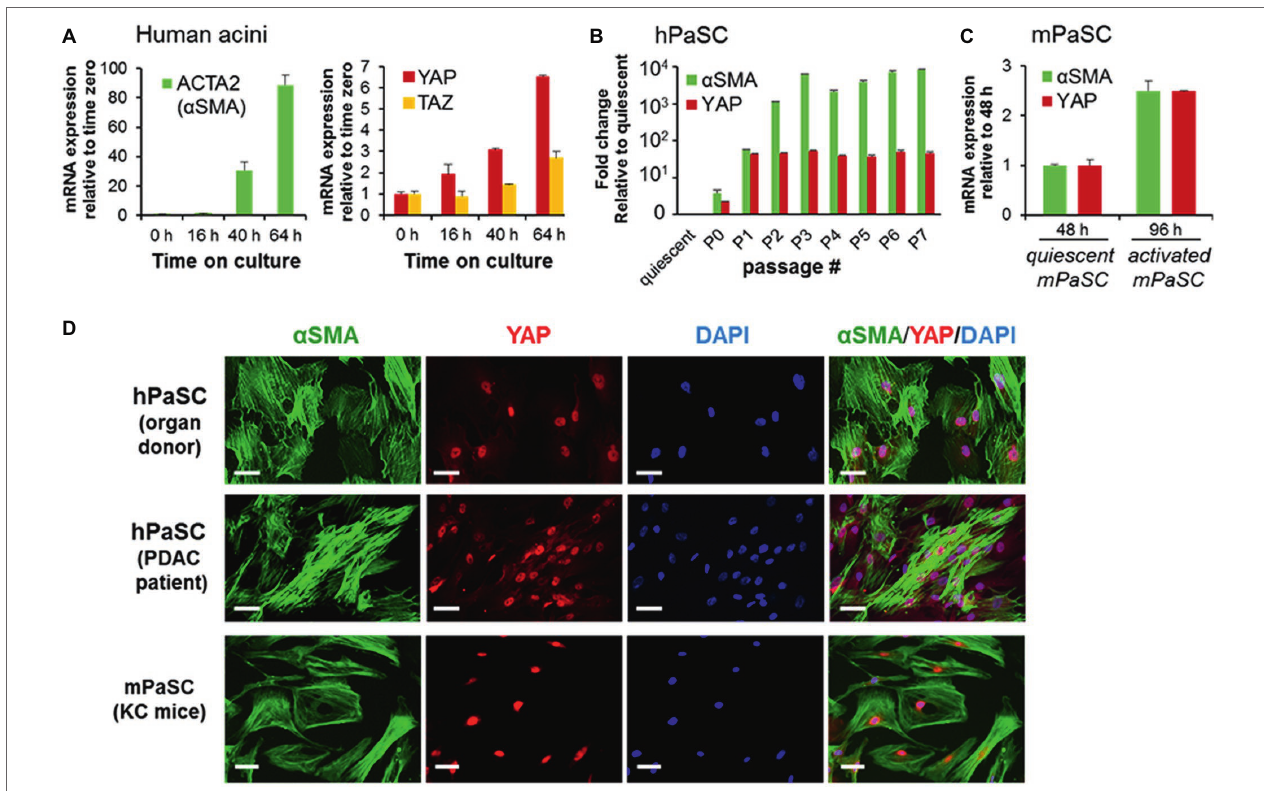
FIGURE 2 | PaSC activation is associated with sustained YAP upregulation. (A) Activated PaSC were obtained in culture from an acinar-ductal-metaplasia (ADM) experimental model using pancreatic acini from cadaveric pancreata from human donors. As sown in the graphs, upregulation of YAP and its homolog TAZ in the ADM system was concomitant with upregulation of α SMA, a recognized maker of activated PaSC. α SMA and YAP mRNA expression were determined by qPCR. (B) Quiescent PaSC isolated from cadaveric human pancreata (hPaSC) did not express YAP, but YAP levels markedly increased during PaSC activation in culture in parallel with upregulation of α SMA. Similar results were obtained in PaSC obtained from WT mouse pancreas (mPaSC) (C) . Graphs in A-C show mean ± SEM; n = 3. (D) Immunofluorescence analysis of YAP (red) and α SMA (green) in hPDAC obtained from cadaveric human pancreata (organ donor) or